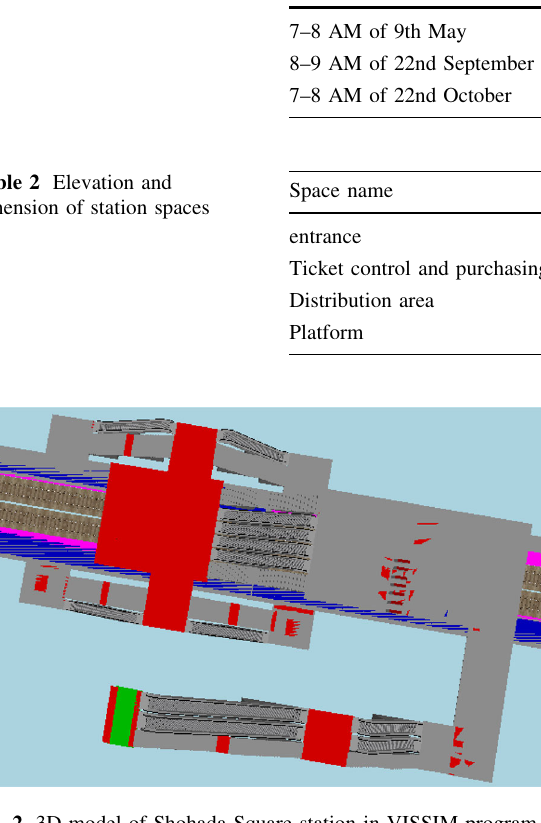
Fig. 2 3D model of Shohada Square station in VISSIM program